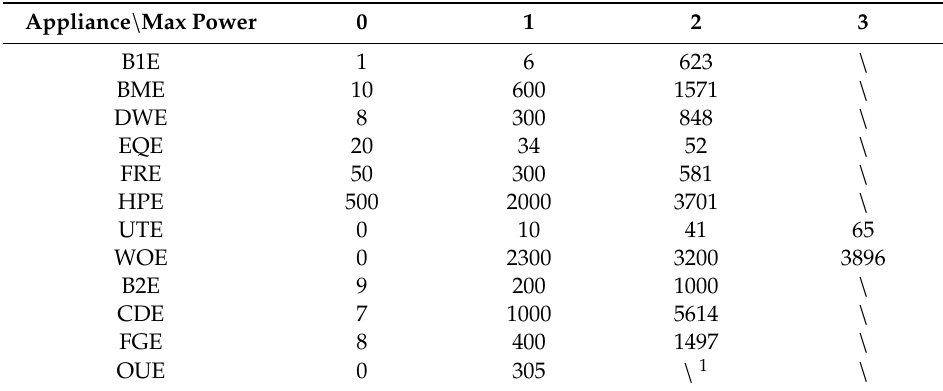
Table 2. Our state quantization results in AMPds2.